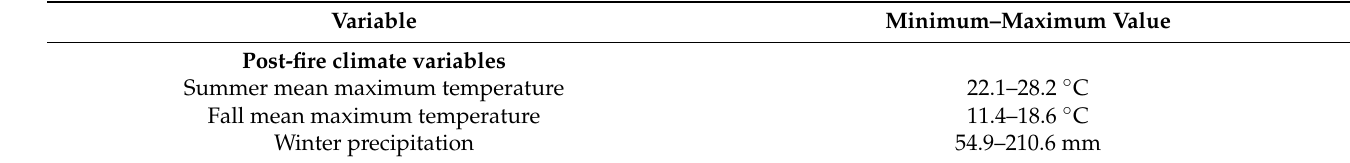
Table 1. Potential predictor variables for non-parametric multiplicative regression (NPMR) models of ponderosa pine seedling density and height growth. Seasonal post-fire climate variables (averaged for the period 2008–2015 to represent post- fire growing conditions) were obtained from ClimateNA (Wang et al. 2016, v. 6.21). Summer was defined as June–August; Fall as September–November; Winter as December–February; Spring as March–May. Burn severity was obtained from MTBS (www.mtbs.gov, accessed on 18 October 2021) and field data were gathered in the summers of 2015 (Hayman and Jasper) and 2016 (Egley). Variables with an asterisk (*) were excluded from the NPMR for seedling